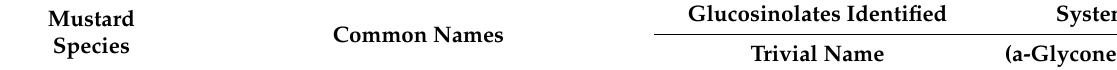
Table 1. Distribution of glucosinolates among mustard plant